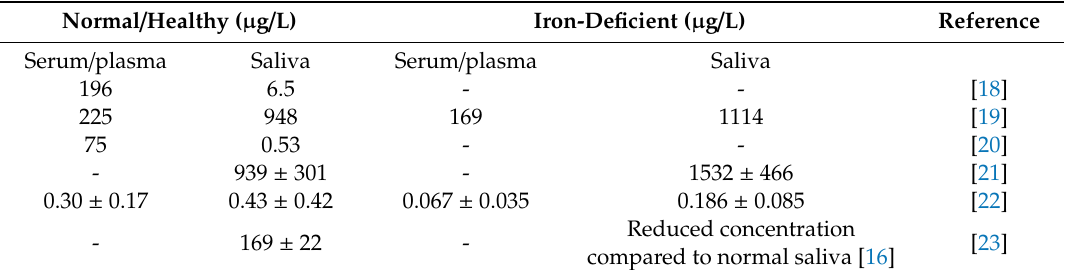
Table 1. Correlating serum / plasma and salivary ferritin concentrations in healthy and iron-deficient (ID) subjects.